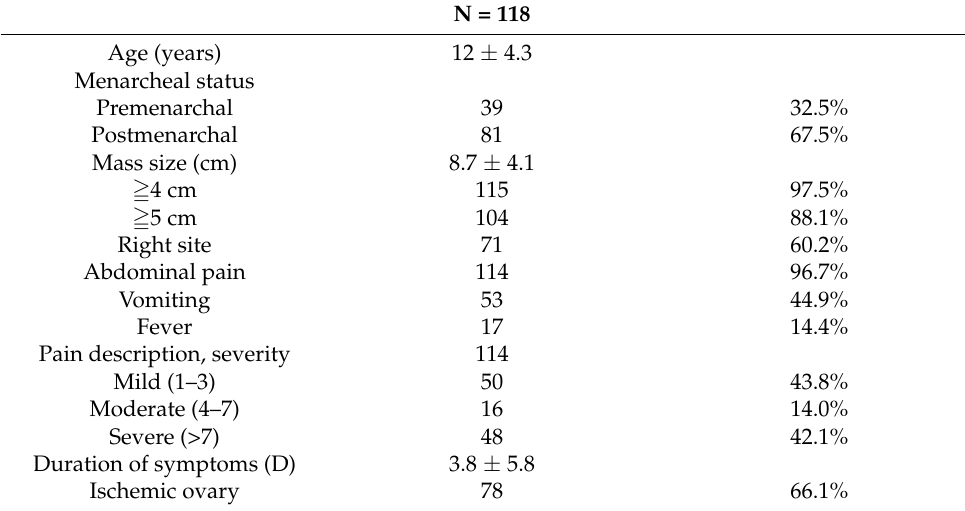
Table 1. Presenting signs and symptoms and descriptive statistics for patients with ovary torsion (N =